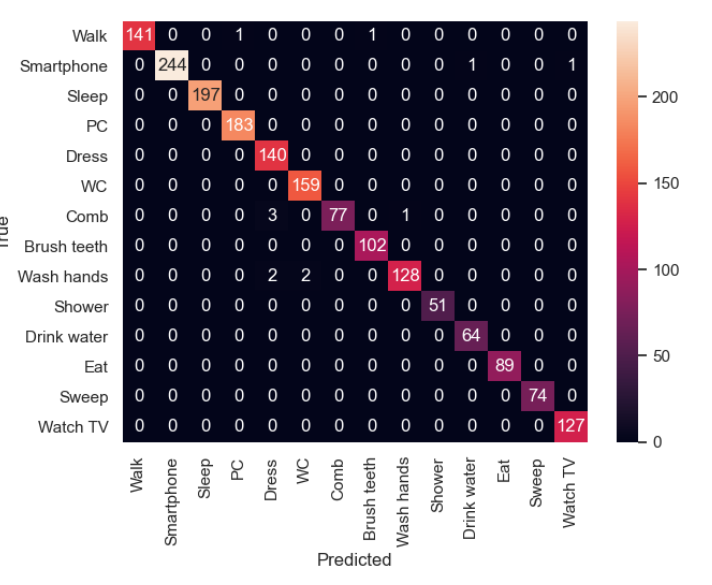
Figure 21. Confusion matrix of the experiment 1.